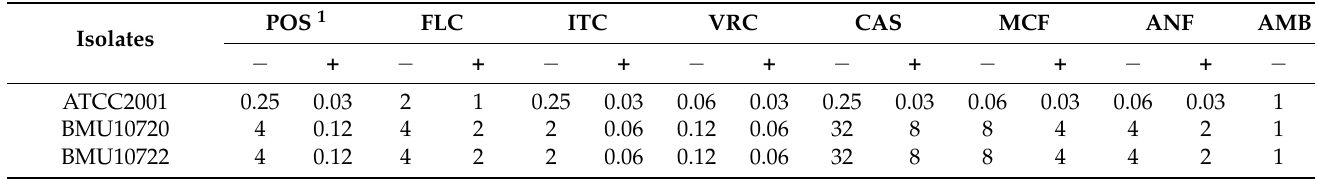
Table 2. Minimal inhibitory concentrations (MICs) (mg/L) of antifungal agents alone or combined with FK520.